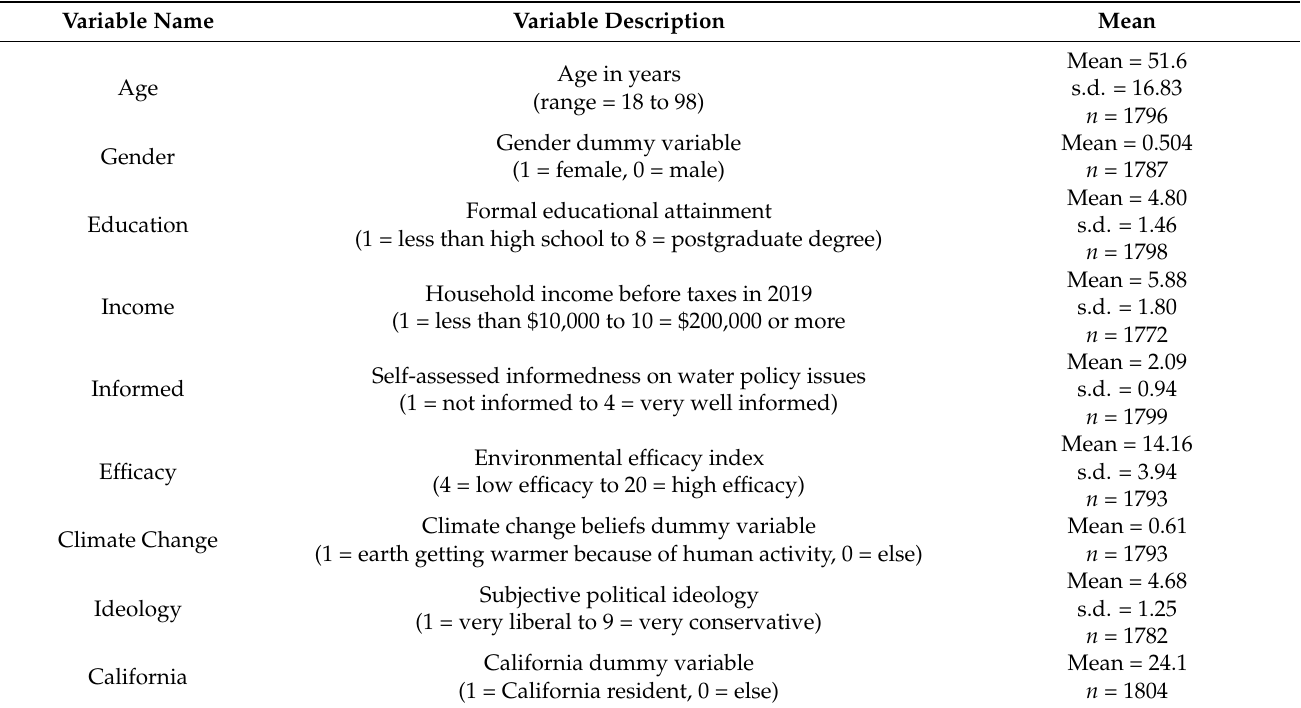
Table 2. Independent and Control